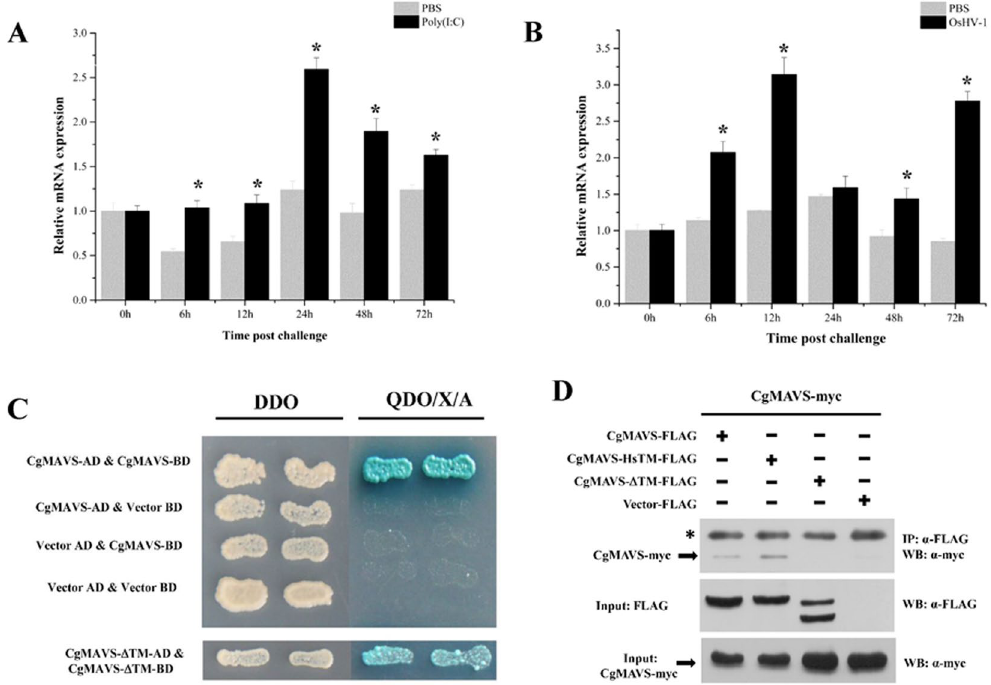
Figure 5. CgMAVS responds to poly(I:C) and OsHV-1 challenges and forms homodimers. (A and B ) Expression profile of CgMAVS after poly(I:C) and OsHV-1 challenges analysed by qRT-PCR. ( D and E ) Dimerization of CgMAVS was analysed by Y2H ( D ) and Co-IP ( E ). DDO: -Leu/-Trp double-dropout media, QDO/X/A: -Ade/-His/-Leu/-Trp quadruple-dropout media with X- α -Gal and aureobasidin. The TM domain of CgMAVS was important in mediating this